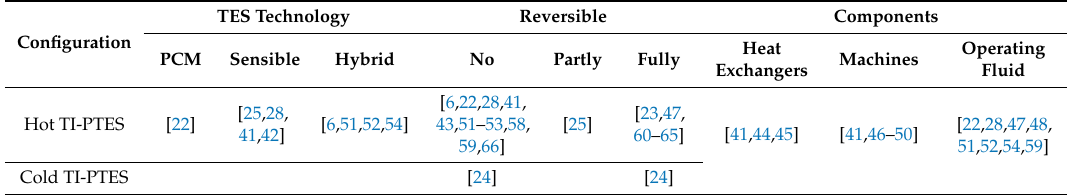
Table 1. Summary of cited studies according to the listed technical topics.